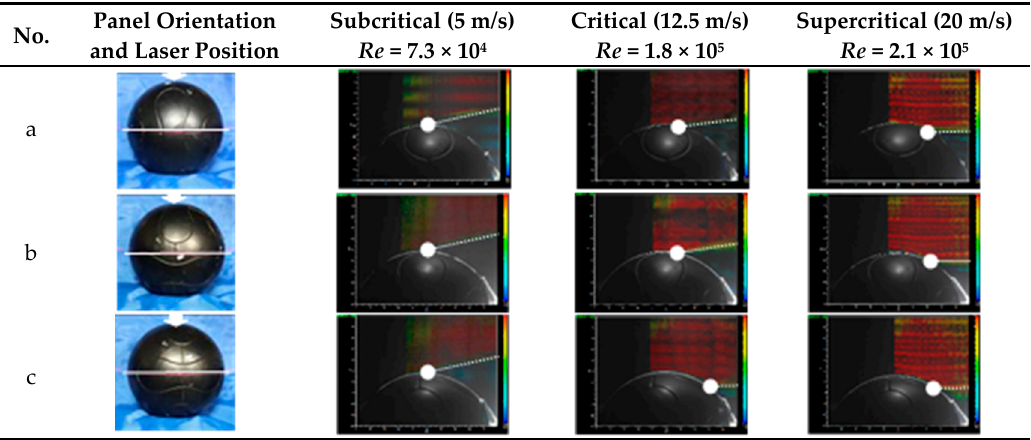
Table 5. The PIV results of the TeamGeist with different panel orientations and different flow